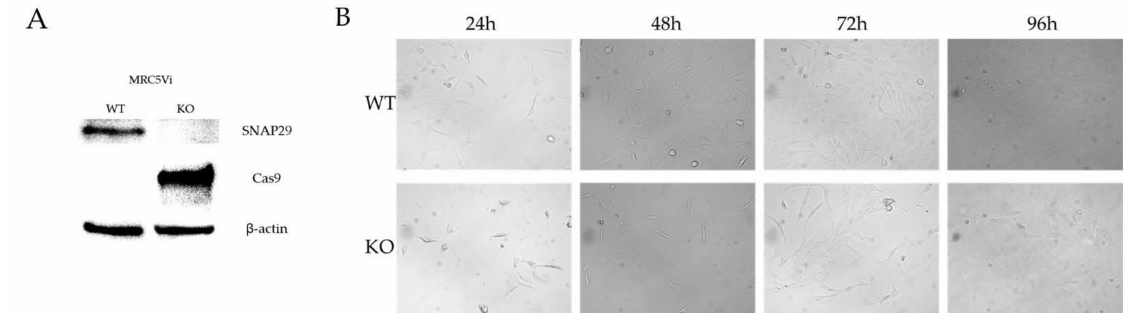
Figure 4. Characterization of SNAP29 knockout (KO) fibroblasts compared to wildtype (WT) fibroblasts. ( A ) Western blot analysis was performed for MRC5Vi SNAP29 KO and WT. Whole-cell protein was separated by polyacrylamide gel electrophoresis (PAGE) and transferred onto a nitrocellulose membrane via semi-dry Western blotting. The presence or absence of SNAP29, Cas9, and the housekeeping protein β -actin was visualized using specific antibodies (actin as control). Raw data is presented in Supplementary Material S1. ( B ) To analyze the cell growth of SNAP29 KO cells, WT and SNAP29 KO fibroblasts were seeded in a 6-well plate at a density of 100,000 cells per well. Cell growth was assessed every 24 h and documented by light microscopy (20 × , scale bar in the lower right: 200 µ